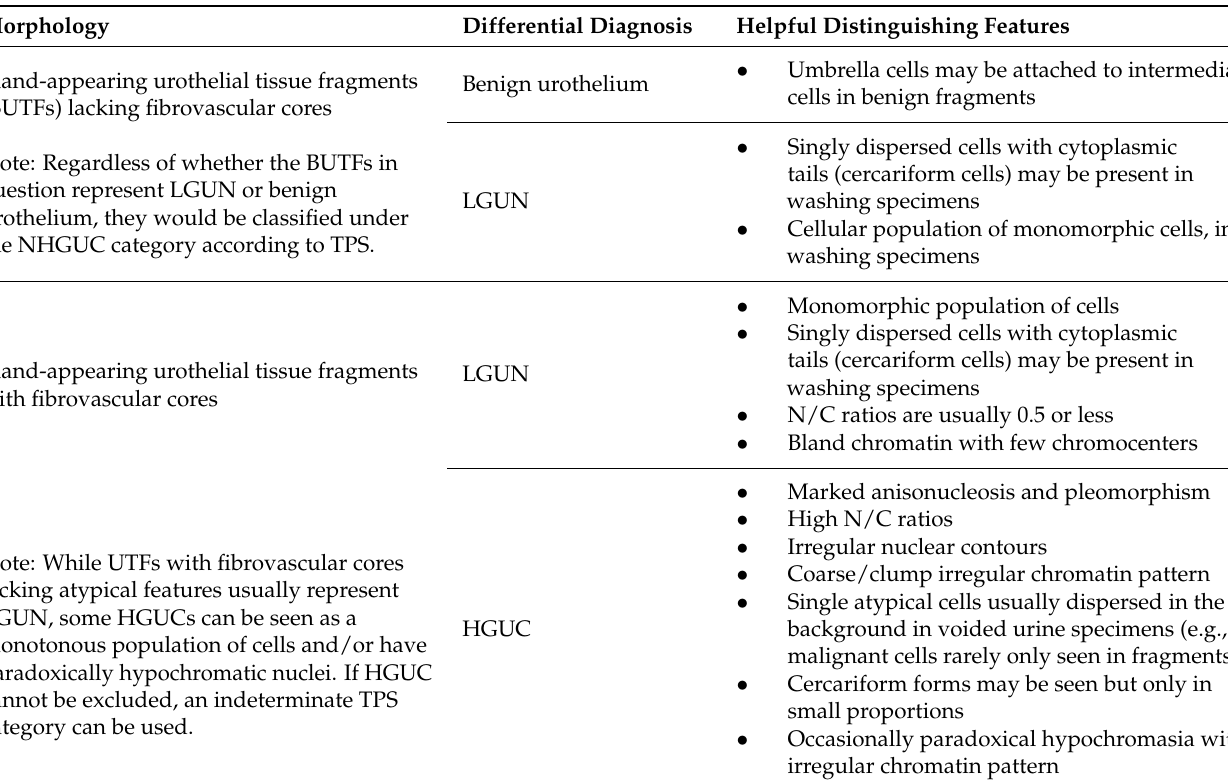
Table 1. Differential diagnoses associated with urothelial tissue fragments based on the morphology seen, and helpful features that may help distinguish between